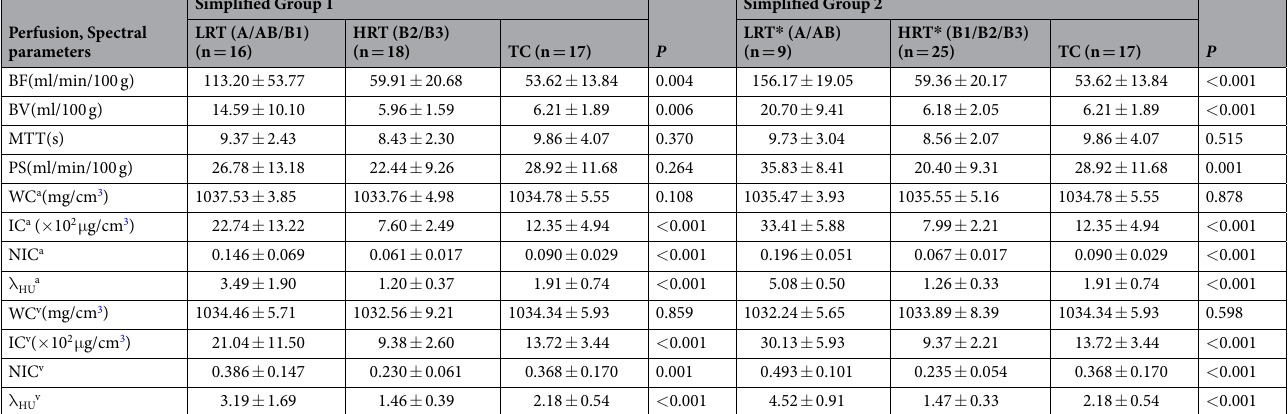
Table 5. Perfusion and spectral parameters in Simplified Groups 1 and 2 of 51 TETs. BF, blood flow; BV, blood volume; MTT, mean transit time; PS, permeability surface. WC, water concentration IC iodine concentration; NIC normalized iodine concentration; λ HU, slope of spectral HU curve. a, the optimal arterial phase; v, the optimal venous phase. TC, thymic carcinoma.